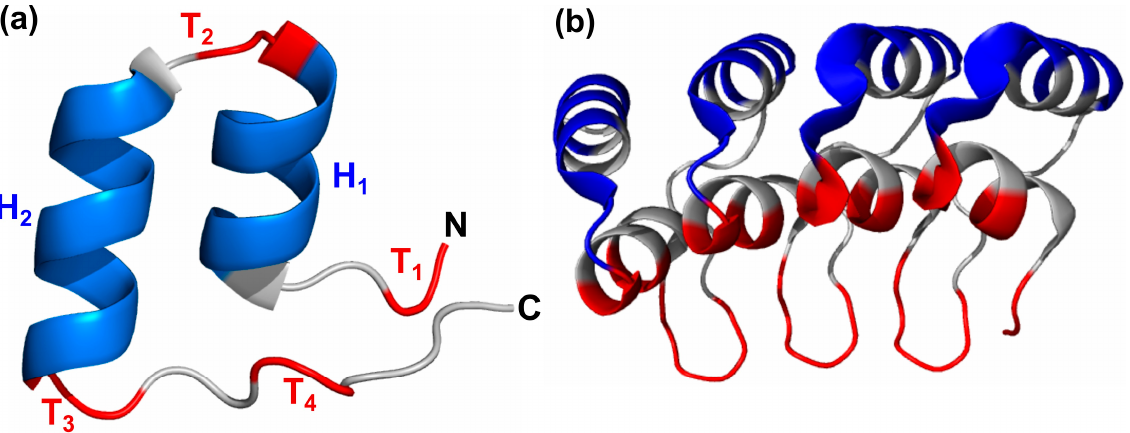
Figure 1. ( a ) The 3D view of Ankyrin repeat motif. The helices are colored blue, turns are red, and the coils are grey. ( b ) The Ankyrin repeat domain in designed Ankyrin repeat protein, 1N0R, comprising 4 repeat copies. The concave surface is highlighted in red, and the convex surface is highlighted in blue